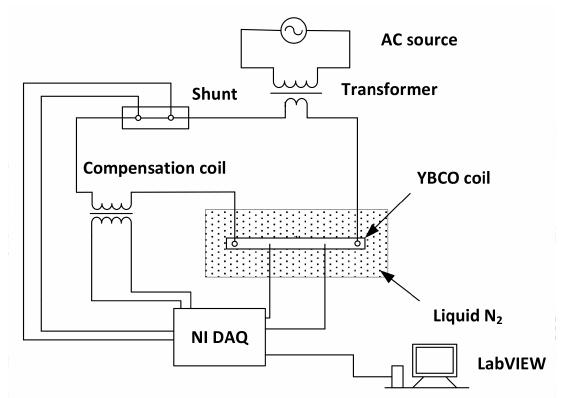
Figure 4. AC loss measurement